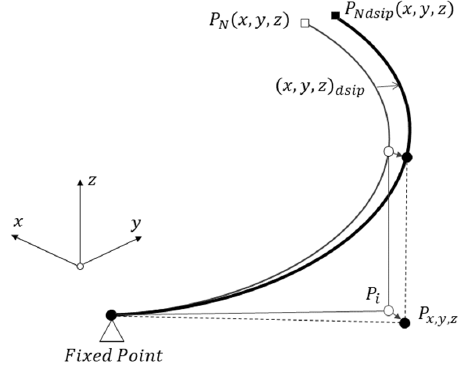
Figure 3. Derivation of control point using inverse method.